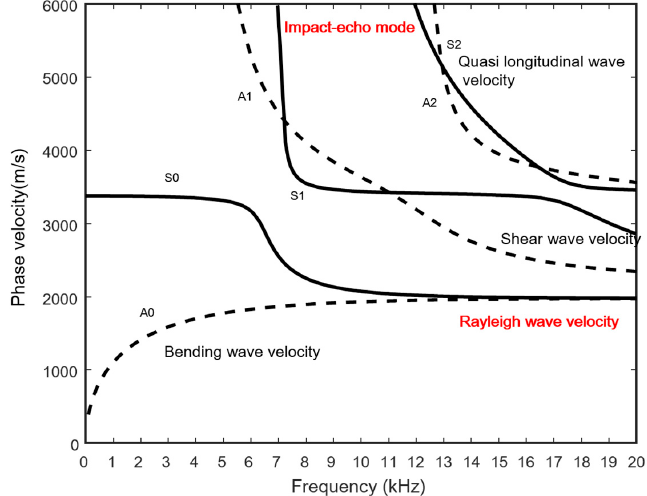
Figure 3. Phase velocity dispersion curves determined by MASW (based on the FE simulation of a concrete slab with a thickness of 0.3 m). A density of 2250 kg/m 3 , an elasticity of 23 GPa and a fixed Poisson’s ratio of 0.167 are assumed for the concrete slab.